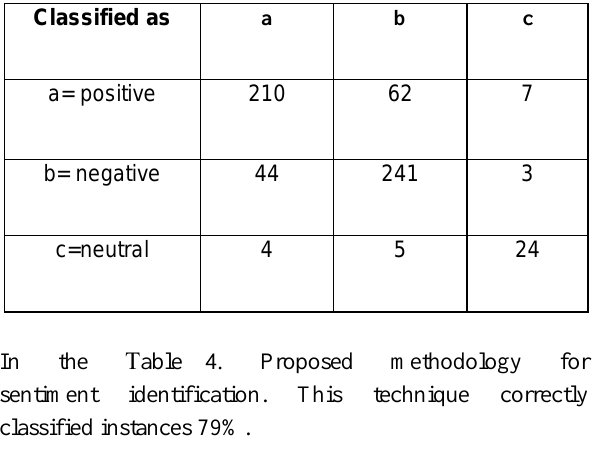
Table 3. Proposed Confusion matrix of BOW